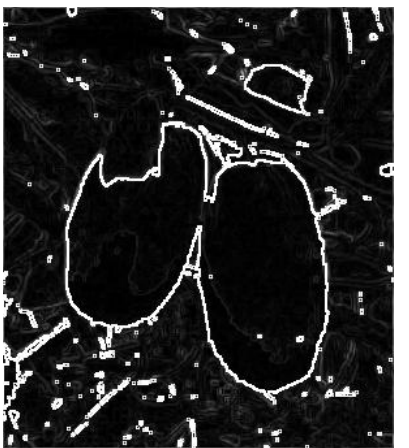
Figure 14. Mask image.